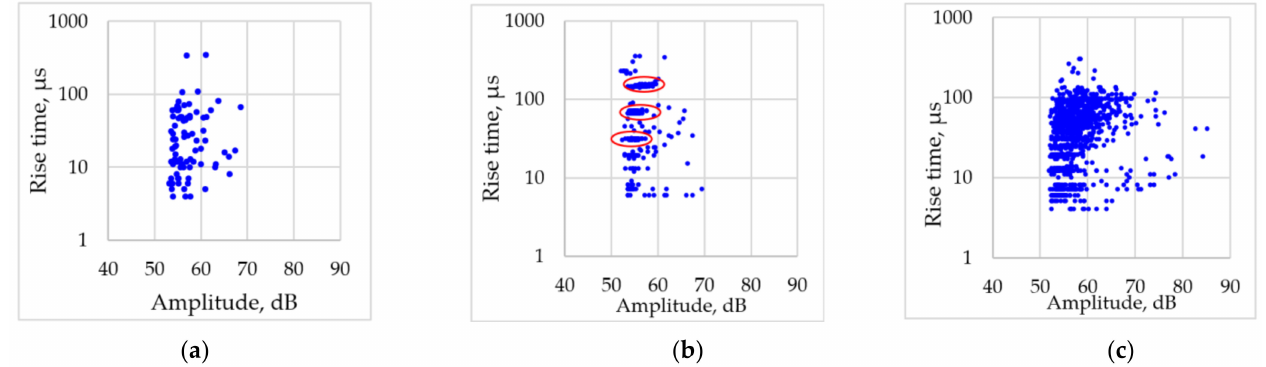
Figure 6. Rise time vs. amplitude scatterplots for AE hits registered under cyclic loading of a defect-free welded joint at σ max = 200 MPa ( a ), σ max = 300 MPa ( b ) and σ max = 400 MPa ( c